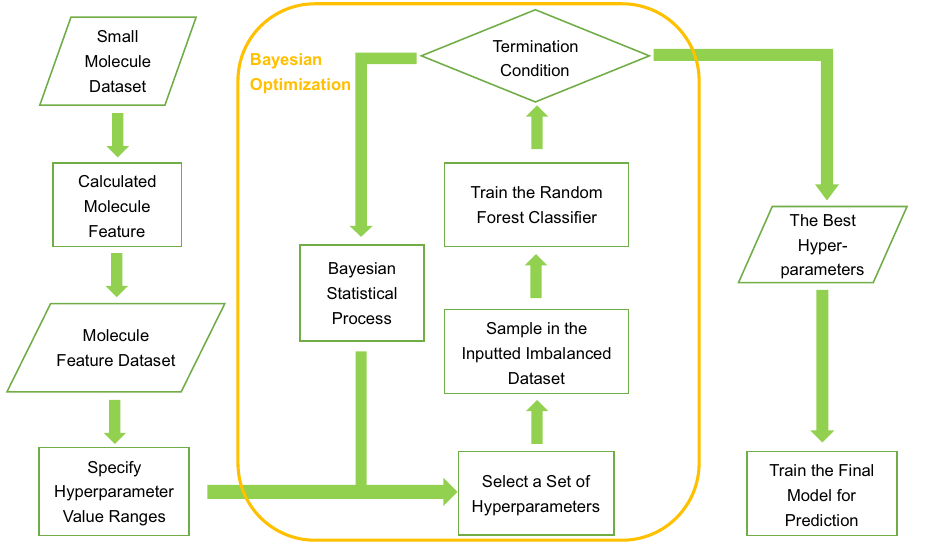
Figure 1. Workflow of the final model